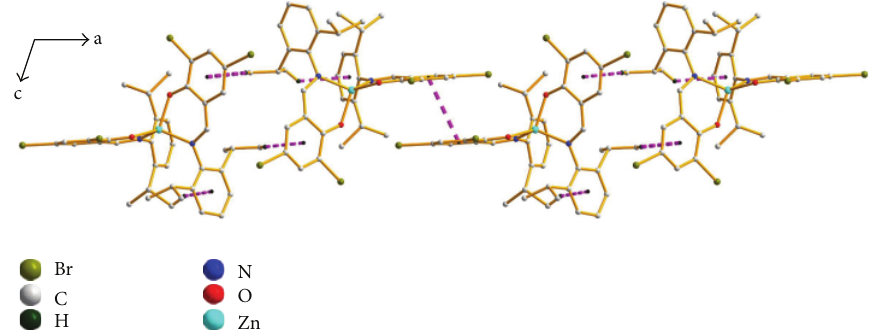
Figure 3: View of an infinite chain of 2 formed by intermolecular 𝜋⋅⋅⋅𝜋 and C–H ⋅⋅⋅𝜋 stacking interactions with pink dashes